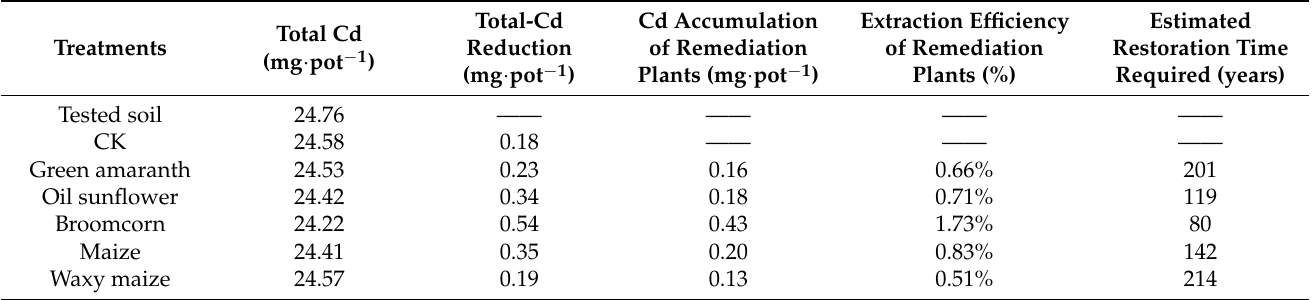
Table 6. Phytoremediation effects of different